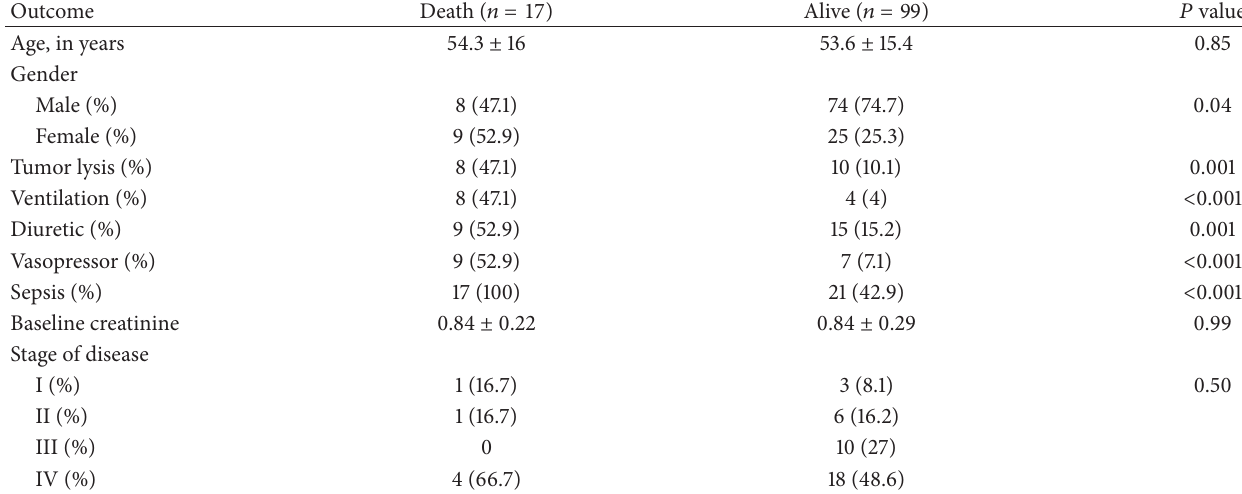
Table 5: Factors associated with mortality in AKI.